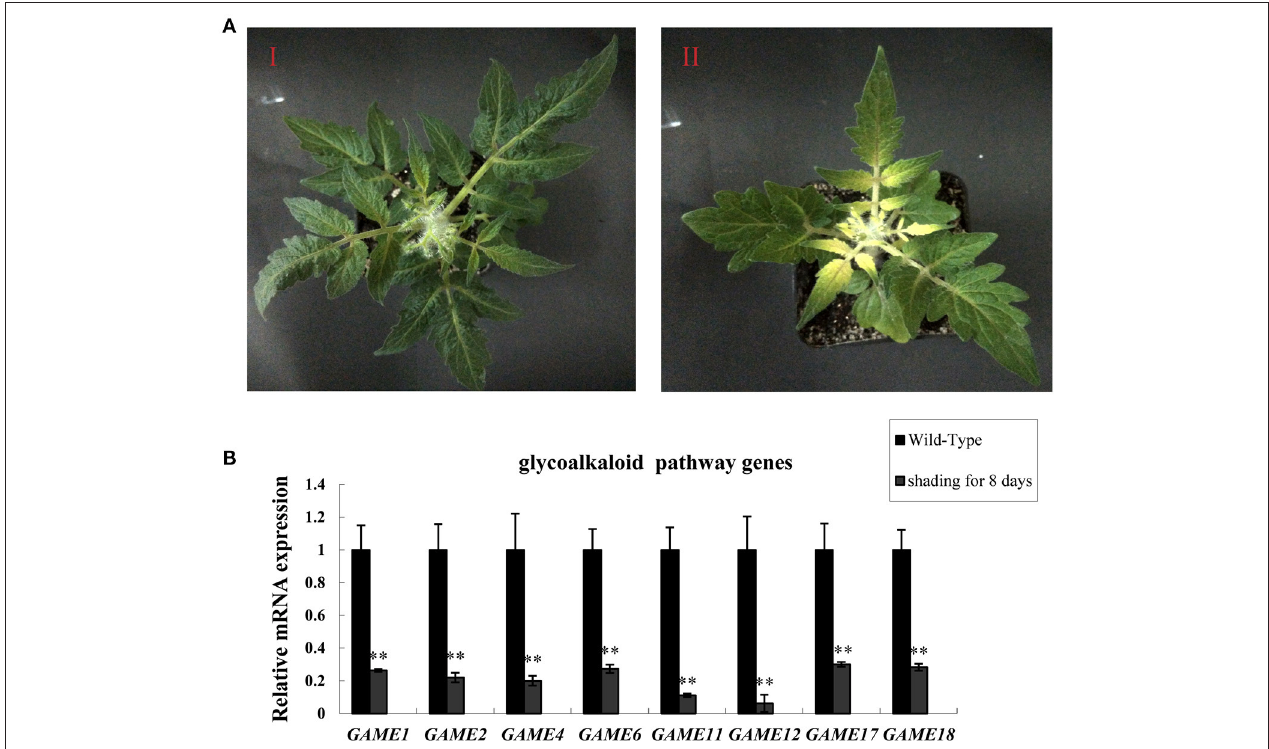
FIGURE 1 | Dark treatment inhibits SGA gene expression in tomato leaves. (A) Phenotypes of tomato leaves kept in the dark. (I) Wild-type tomato leaves from plants in the light (II) Tomato leaves in the dark for 8 days. (B) GAME mRNA relative expression, measured by qRT-PCR. Data are the mean ± standard deviation of three biological replicates. Student’s t- test indicates significant changes from control plants: * P -value < 0.05; ** P -value < 0.01. Primers designed for Real-time quantitative RT-PCR are listed in Table S1 .